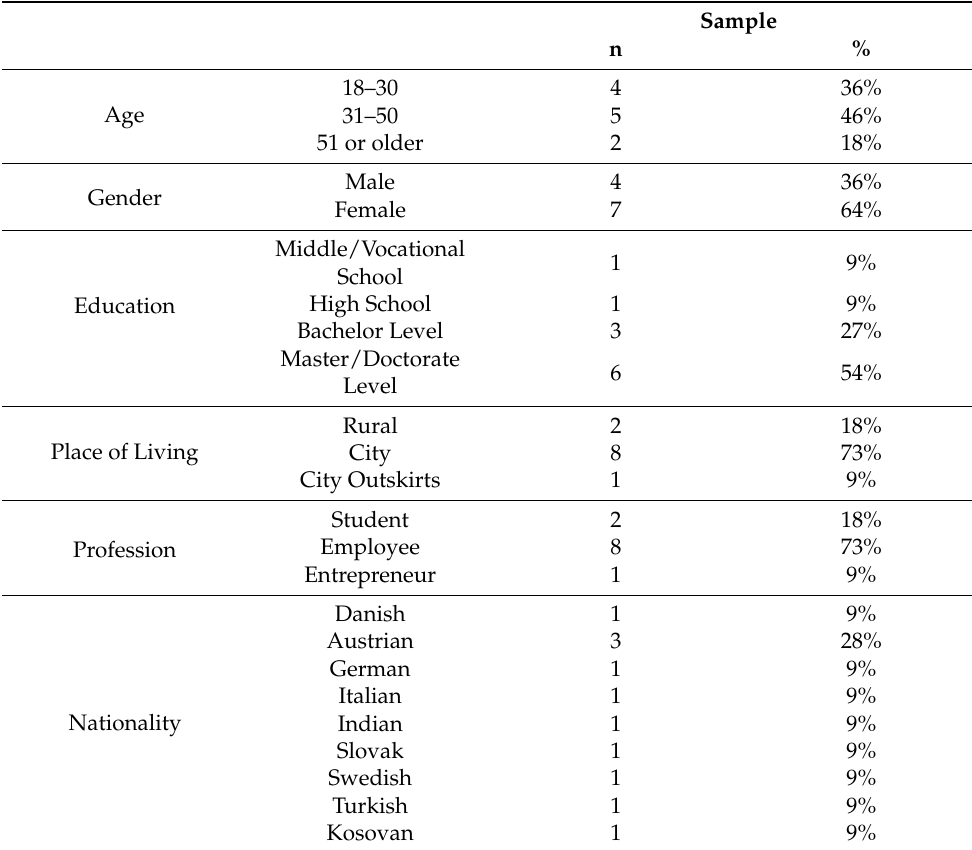
Figure 9. Mean Scores of Engagement, Functionality, Aesthetics, and Information in Two Studies. Table 1. Sociodemographic variables—sample